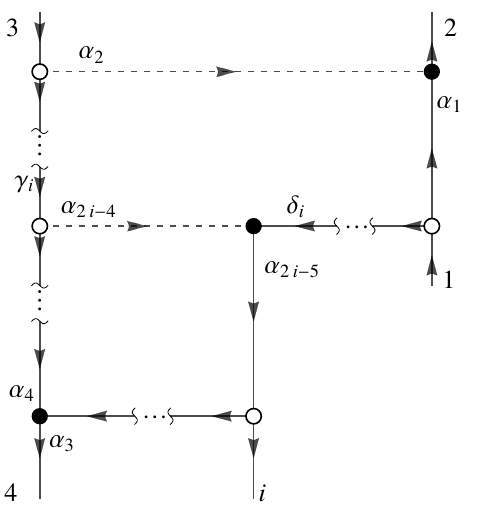
Figure 25 . On-shell diagram showing how 4-point seed amplitude orientation is cut, and an inverse soft factor is inserted for i 2 f 5 ; : : : n g